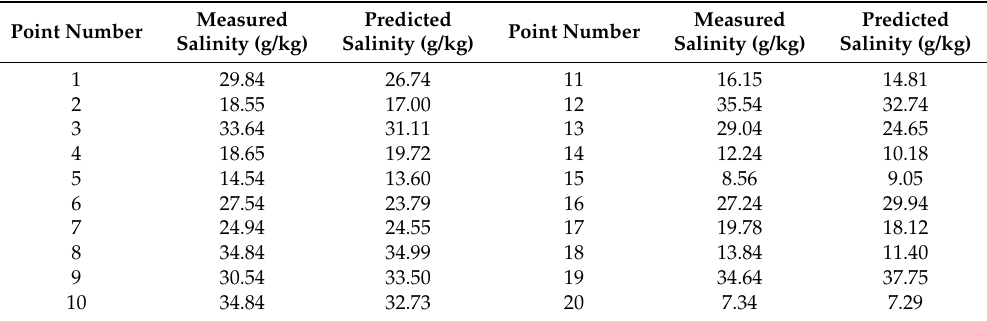
Table 3. Measured and predicted soil salt content.